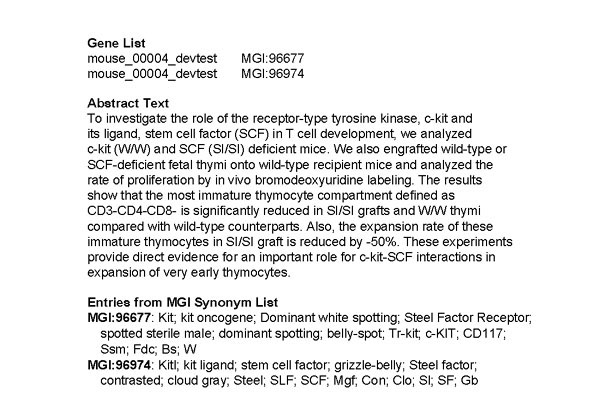
Sample abstract with unique gene identifiers, plus excerpt from lexicon.